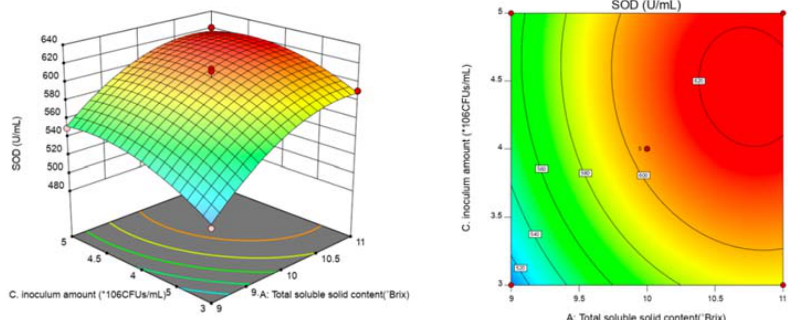
Figure 2. The influence of the interaction of factors on the SOD activity of CFJ.